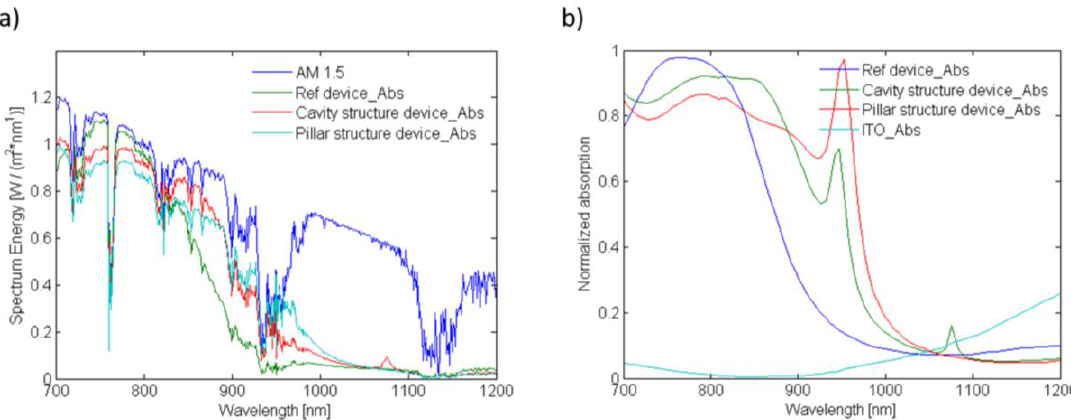
Figure 4. The light absorption spectra for PbS colloidal quantum dot (CQD) layer incorporated into different ITO structures normalized to ( a ) AM1.5G spectra and ( b ) simulation light source. The absorption enhancement for both cavity and pillar structures over the reference flat structure is obvious especially at resonance wavelengths of 950 nm for both structures and 1080 nm for cavity arrays. A slight absorption loss by ITO layer was also observed, as shown in Figure 4b.